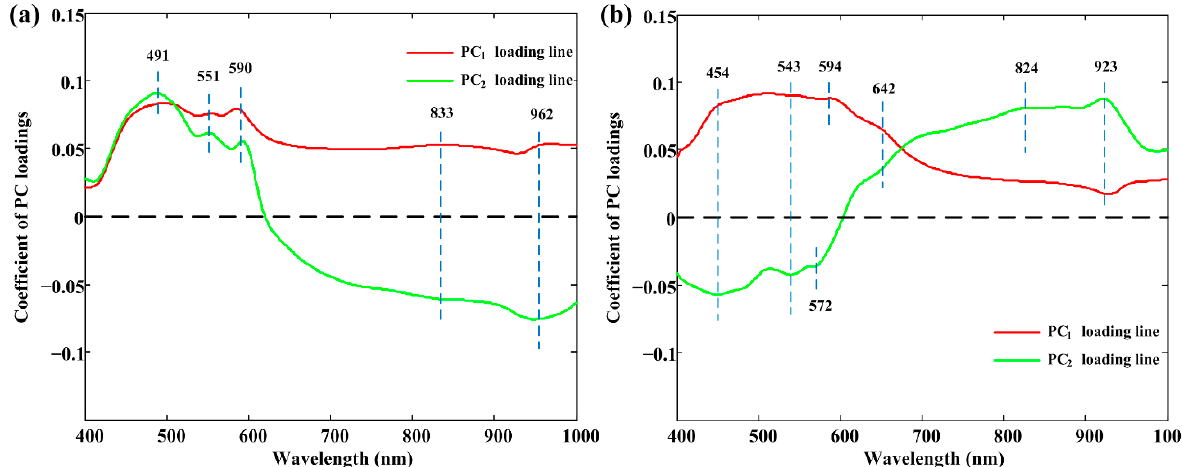
Figure 4. The PC 1 and PC 2 loading lines for spectra collected from ( a ) raw and ( b ) cooked meat rolls. PC: principal component.